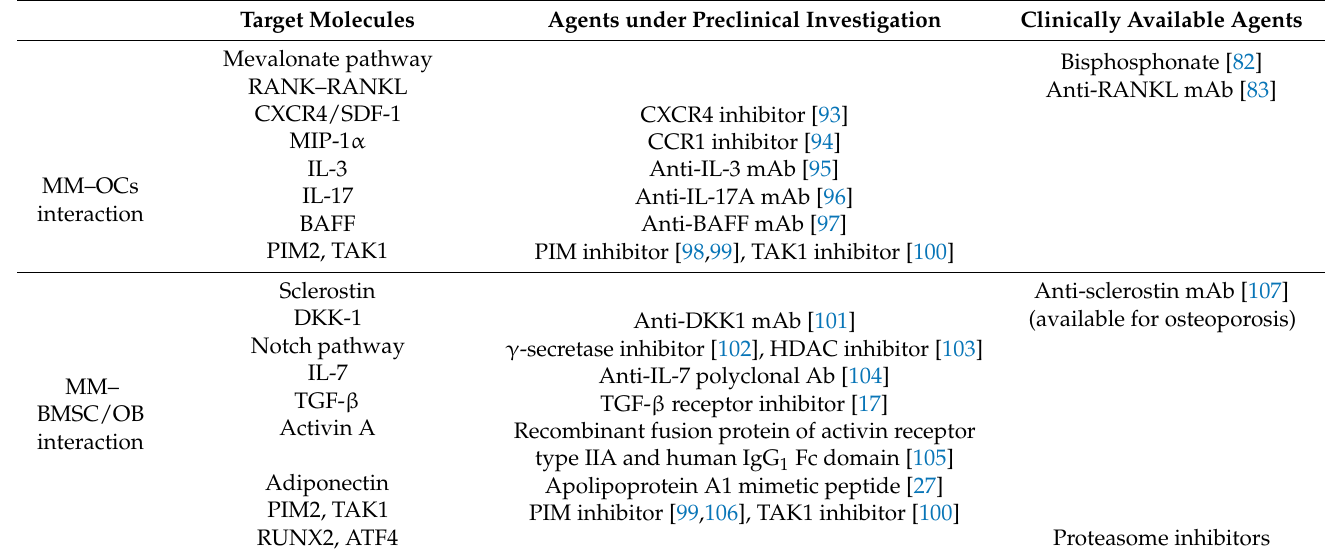
Table 1. Therapeutic targets for MM–bone